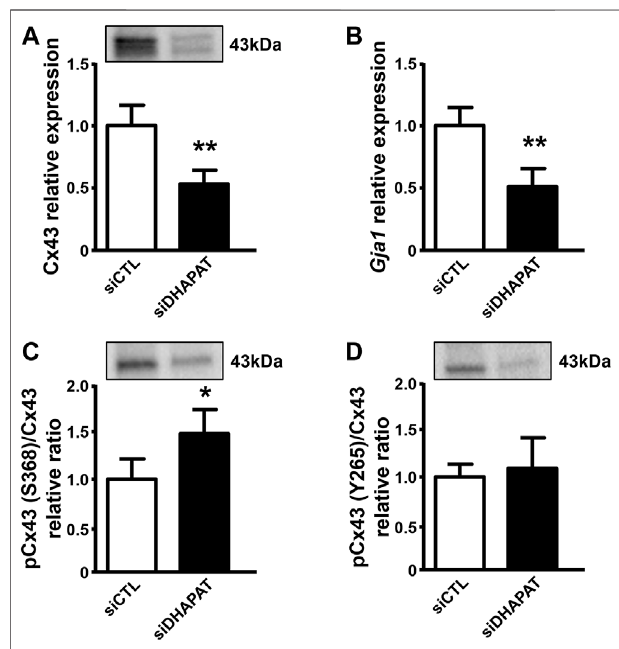
( Figure 5A ). RT-qPCR analyses further showed that Gja1 expression was also signi fi cantly downregulated in siDHAPAT-transfected Müller cells ( − 47%, p < 0.01) ( Figure 5B ). In order to determine whether other Cx43- dependent mechanisms are involved in Cx43 downregulation, we assessed Cx43 phosphorylation status, as it was shown that phosphorylation of Cx43 on S368 and Y265 residues triggers its degradation through the ubiquitin-proteasome pathway (Leithe